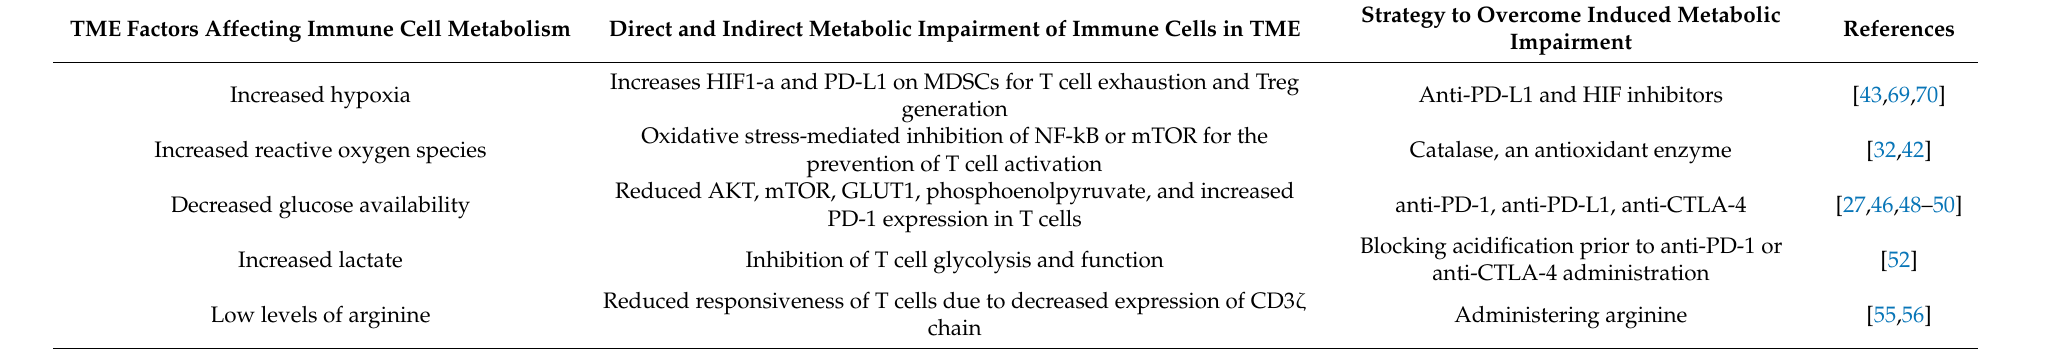
Table 1. Summary of TME mediated modulation of